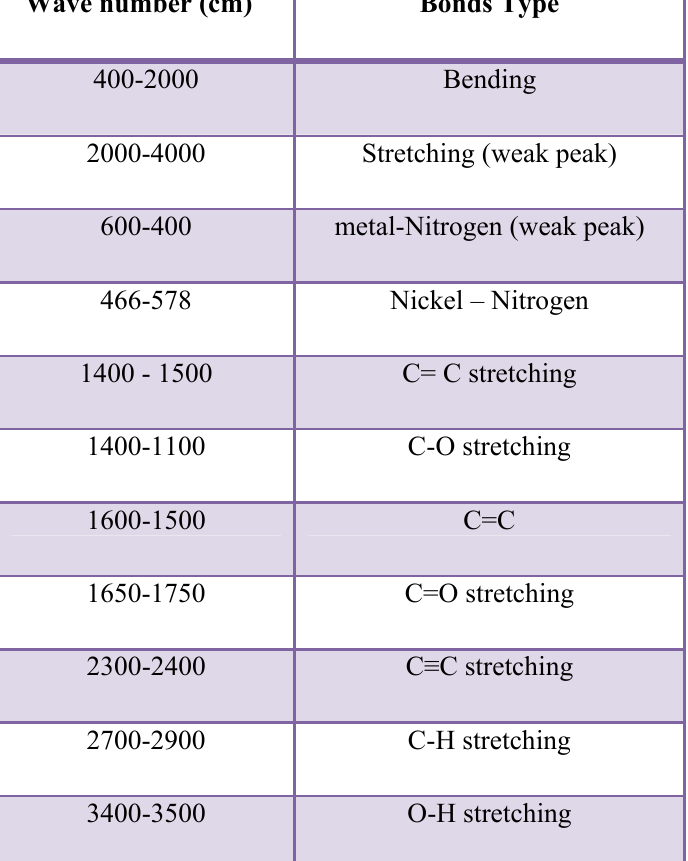
Table 3: The bond of NiPcTs/PEDOT:PSS bulk heterojunctions blend thin